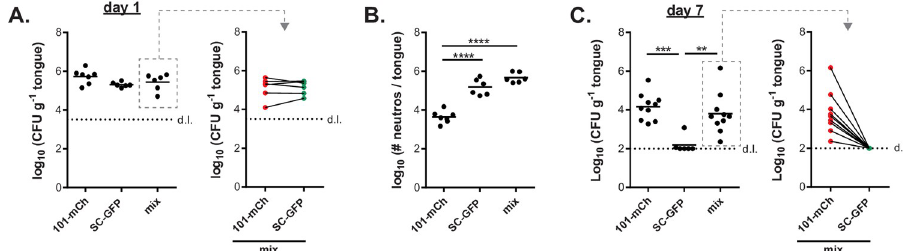
Fig 3. Isolate 101 persists in the oral mucosa even in presence of SC5314-induced inflammation. A-C. C57BL/6 WT mice were infected sublingually with a 1:1 mixture of isolates 101-mCherry (101-mCh) and SC5314-GFP (SC-GFP) or with either isolate alone. On day 1 ( A ) and on day 7 ( C ) the total tongue fungal burden was quantified (left panels). From the co-infected animals, the colonies were further analysed for mCherry- and GFP-expression (right panels). Quantification of tongue-infiltrating neutrophils by flow cytometry on day 1 post-infection is shown in B . Each symbol represents one animal. The mean of each group is indicated. Data in A and B are pooled from 2, data in C are pooled from 3 independent experiments. d.l., detection limit. Please see also S1 Fig .